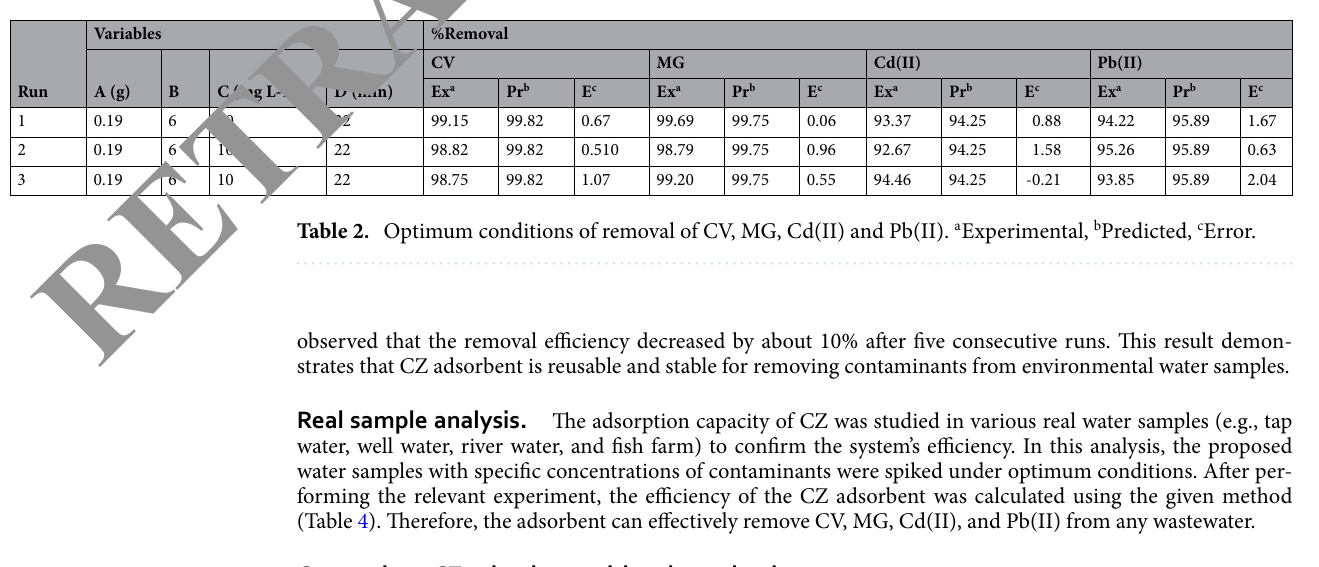
Figure 5. Three-dimensional plots of the interaction effects between variables and removal of ( a ) CV, ( b ) MG, ( c ) Cd(II), and ( d ) Pb(II).